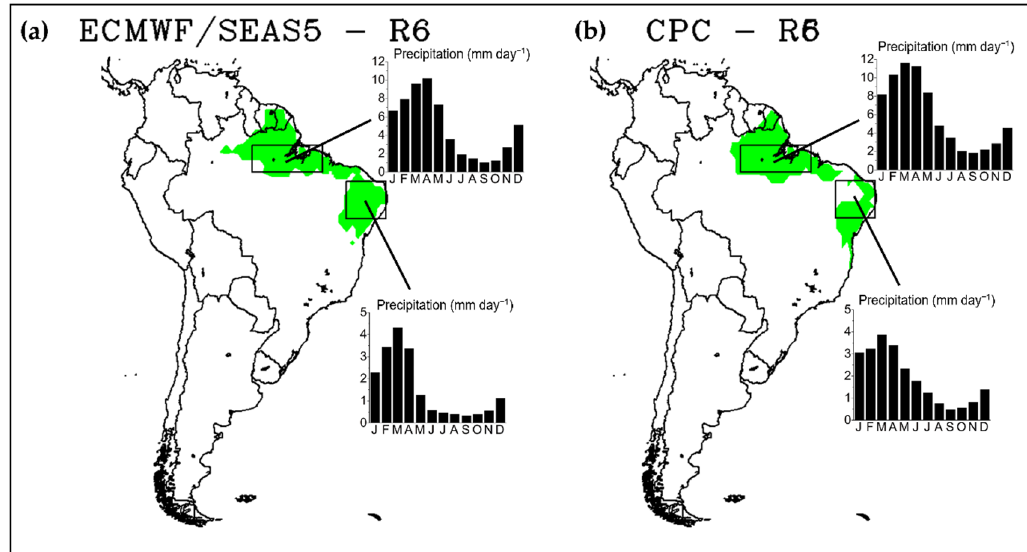
Figure 11. Similar to Figure 6, except for Region 6 (R6). ITCZ is the most relevant atmospheric system in the northern NEB and semiarid